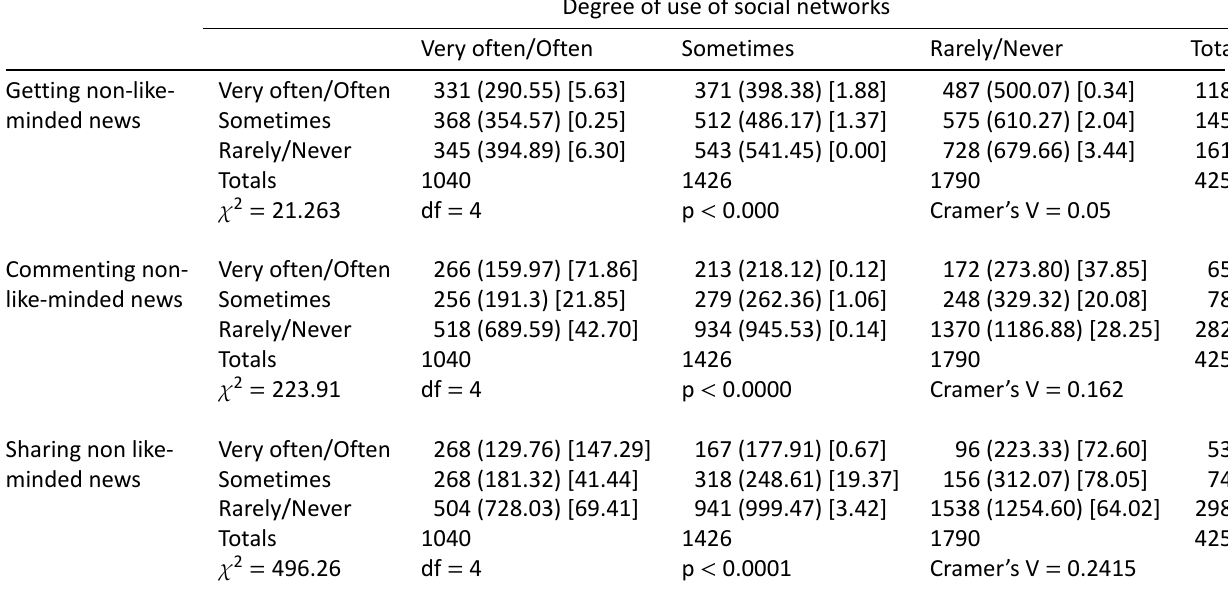
Table 2. Chi-square test for independence.